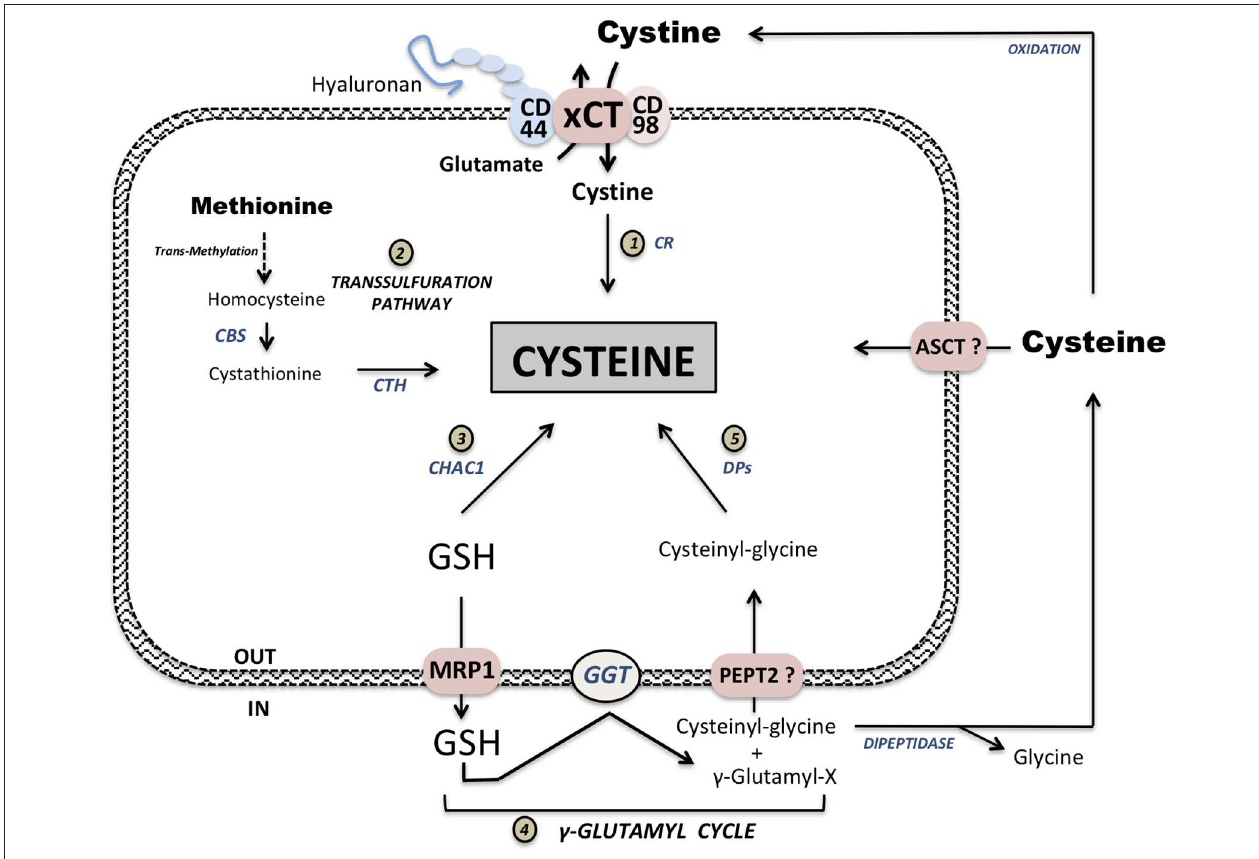
FIGURE 1 | Intracellular cysteine pool supply. Extracellular oxidized cystine is imported at the expense of one glutamate molecule via Xc − system composed of two subunits: xCT transporter and the chaperone CD98. This complex xCT is also associated with the stem-like cancer cell marker CD44 v . Imported cystine is then reduced to cysteine by cystine reductase (CR) ( 1). Methionine conversion leads to cysteine synthesis via the transsulfuration pathway (2). Two important steps in this synthesis are conversion from homocysteine to cystathionine by cystathionine β -synthase (CBS) and synthesis of cysteine from cystathionine by cystathionase (CTH). Degradation of glutathione (GSH) via CHAC1 intracellularly provides cysteine supply ( 3). GSH, either from exogenous sources or exported from cells via Multidrug Resistance Protein 1 exporter (MRP1), is cleaved extracellularly by γ -Glutamyl transferase (GGT) forming γ -Glutamyl-X substrate and Cysteinyl-Glycine. This Cysteinyl-Glycine dipeptide can either be potentially transported via PEPT2 or cleave by dipeptidase releasing cysteine and glycine ( 5). γ -Glutamyl moiety can be complexed to available extracellular cyst(e)ine forming γ -Glutamyl-cysteine. Cysteine supply from GSH is one of the main function of γ -Glutamyl-cycle ( 4).